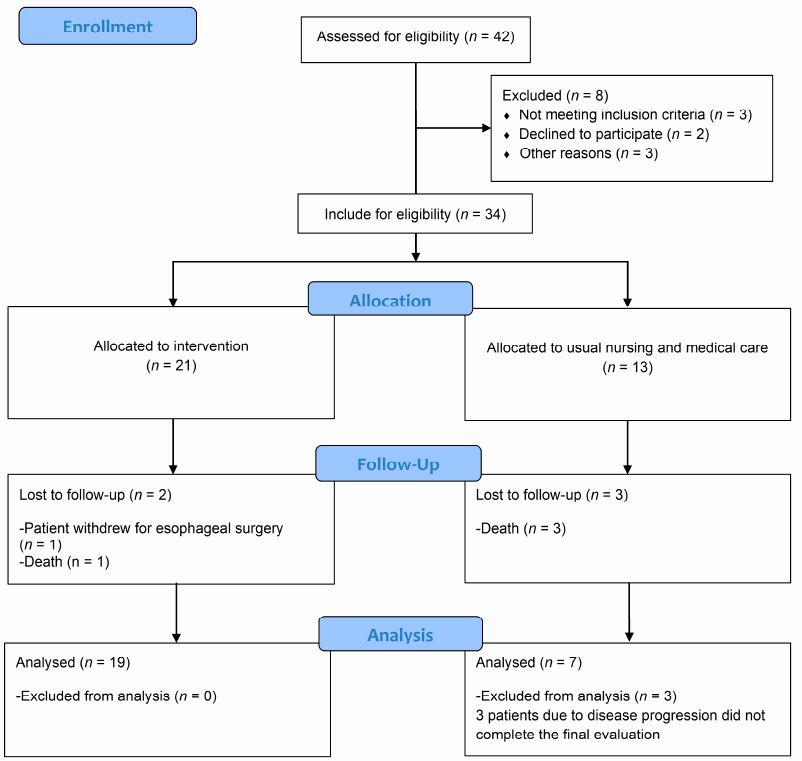
Figure 1. CONSORT Flow Diagram - modified for non-randomized trial design. Table 2. Baseline characteristics of the participants.